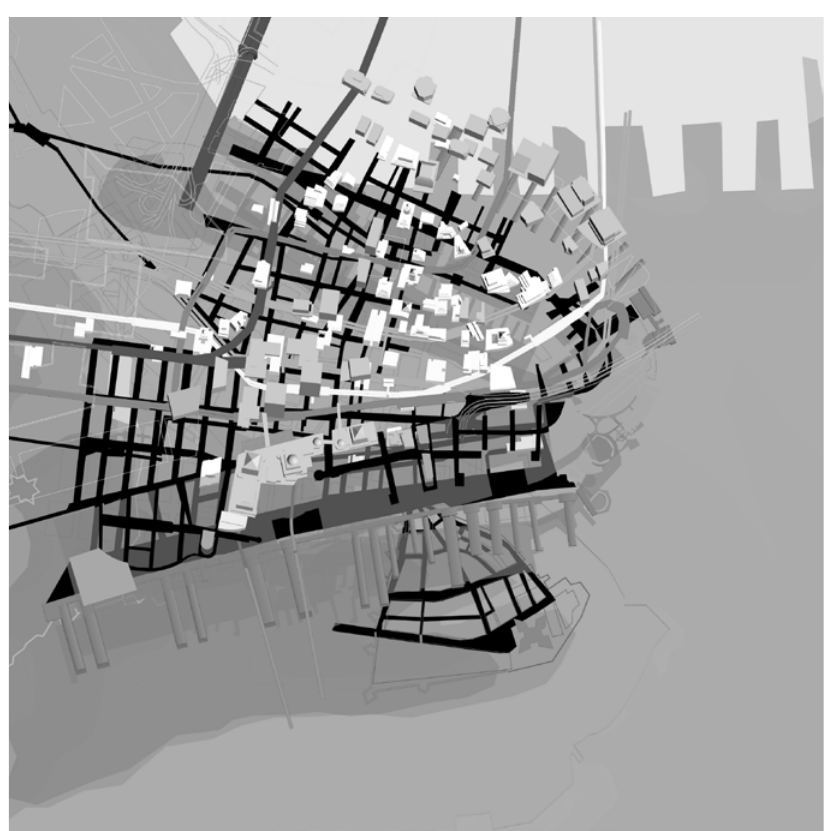
Figure 3. Still from New York Here and